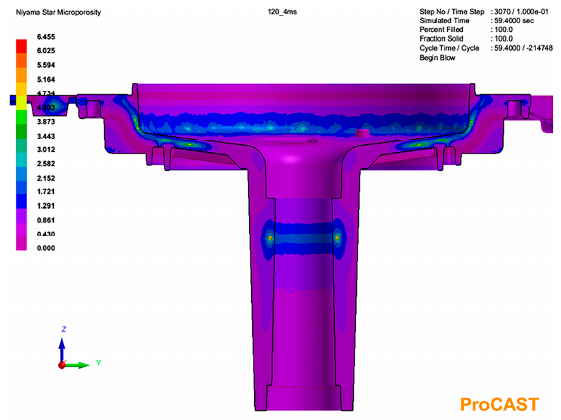
Figure 6. Microporosity simulation result.